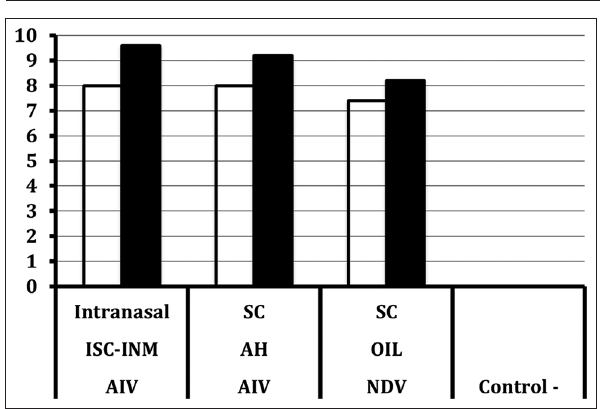
Figure-1: The geometric mean titer of anti-Newcastle disease virus (NDV) antibody titer (−log2 hemagglutination inhibition unit) of chicken sera following administration of commercial inactivated NDV vaccine combined with inactivated AIV-H5N1 AI3G. The NDV and AIV vaccines were given at 3-week-old chicken and booster vaccination was done 2 weeks thereafter. The intranasal vaccine was added with ISCOMS (ISC) and Inmunair. One group of chicken was injected subcutaneously with inactivated AIV- H5N1 vaccine with aluminum hydroxide as an adjuvant. The NDV vaccine was also subcutaneously administered. One group of chicken was left without vaccine for treatment and experiment